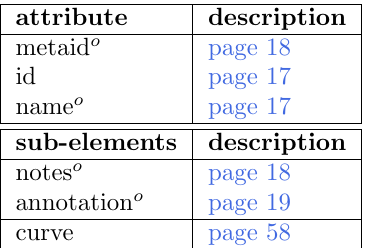
Table 2.25: Attributes and nested elements for plot2D. xy o denotes optional elements and